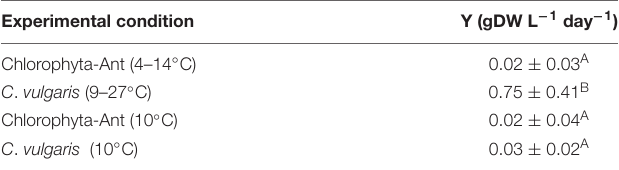
TABLE 2 | Biomass yield rates calculated from biomass dry weight measurements (Chlorophyta-Ant) and OD 690 conversion ( Chlorella vulgaris